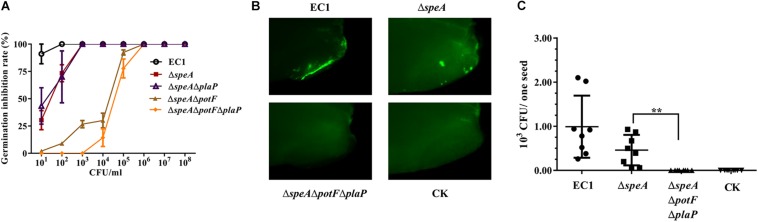
Deletion of speA and putrescine transporters attenuated bacterial invasion and virulence of D. zeae EC1 on rice seeds. (A) Rice seed germination assay. Rice seeds were socked in bacterial suspension containing various amounts of bacterial cells as indicated for 5 h before transferred to plates with moisturized filter papers. The germination rates were counted 5 days later. (B,C) Rice seed invasion assay. Strain EC1 and derivatives were labeled with GFP by in trans expression of the gfp gene. Rice seeds were treated with 100 bacterial cells per mL for 5 h, and then incubated for 24 h at 28°C. The husks of rice seeds were removed for examination under a fluorescence microscope (B) and for bacterial CFU counting (C). The representative photographs were presented and the data shown are the means ± SE (n = 3). ∗∗P < 0.01.